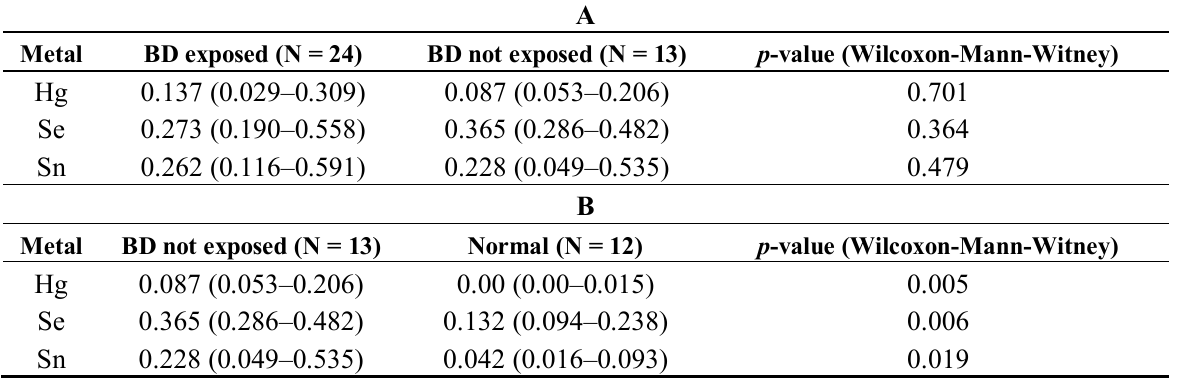
Table 3. Part A. Comparison of metal load (ppm) between children with BD whose parents were exposed directly to attacks and their remnants (exposed, N=24) and those without acute exposure (not exposed, N=13). Median values (and Interquartile range) are shown for the relevant contaminant elements. P refers to comparison between the two groups. Part B. Comparison of metal load (ppm) between children with BD whose parents were not acutely exposed to attacks (not exposed, N=13) and normal children (N=12). Median values (and Interquartile range) are shown for the relevant contaminant elements. P refers to comparison between the two groups.